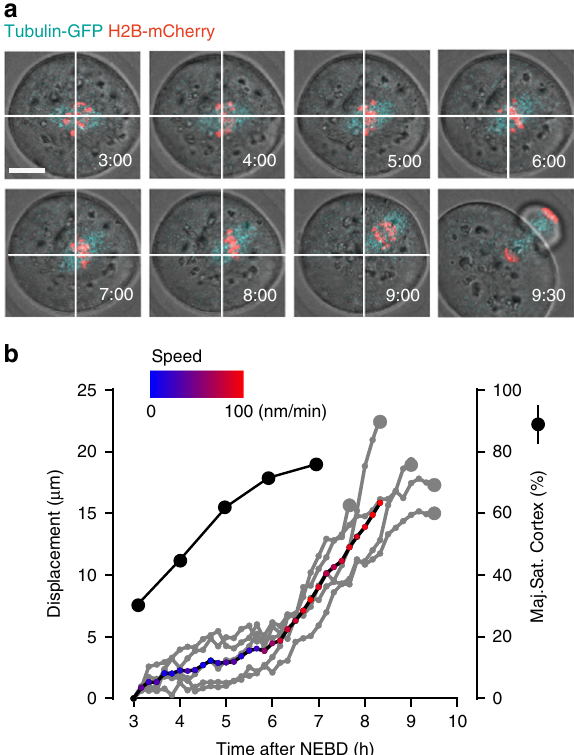
Fig. 3 Chromosome re-orientation precedes spindle migration to cortex. a Bivalent migration to the oocyte cortex in a representative oocyte (H2B- mCherry, red; α -Tubulin-GFP, cyan). Times (h:mm) are relative to NEBD. White cross shows chromosome centre of mass at 3:00 h. Scale bar is 20 μ m. b Displacement of chromosomes (grey, n = 5 oocytes combined from two independent experiments) between 3 and 10 h after NEBD. Displacement is relative to the starting image. The red/blue line represents the mean displacement of all bivalents, with speed colour coded as indicated (blue = 0 nm min − 1 , red = 100 nm min − 1 ). For comparison the timing of the driving bivalent re-orientation is shown (% of bivalents Maj. Sat. cortex, n = 29 oocytes, black line, combined from fi ve independent experiments). Such re-orientation of the driving bivalent preceded spindle migration. Larger grey circle shows the timing of anaphase for each